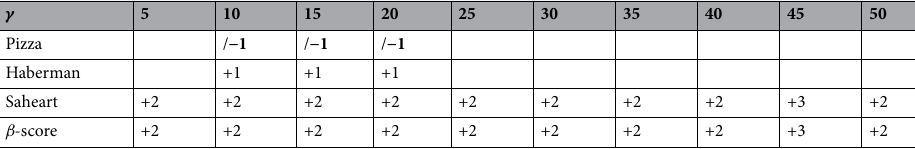
Table 6. Summary of the results, by data set, for different values of the cost ratio γ = boxes indicate for how many classifiers, of the possible 3, there is statistical significance in favor of BOSME (positive) or in favor of ROSE (negative, in bold). For each value of γ , we take count of the β